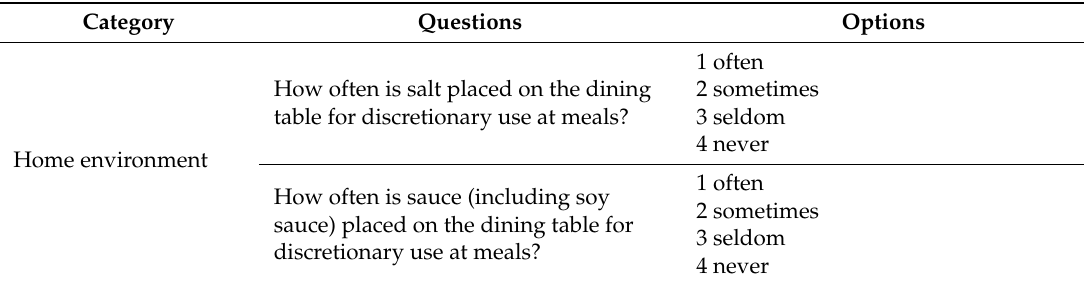
Table 1. Questions about home environment, knowledge, and